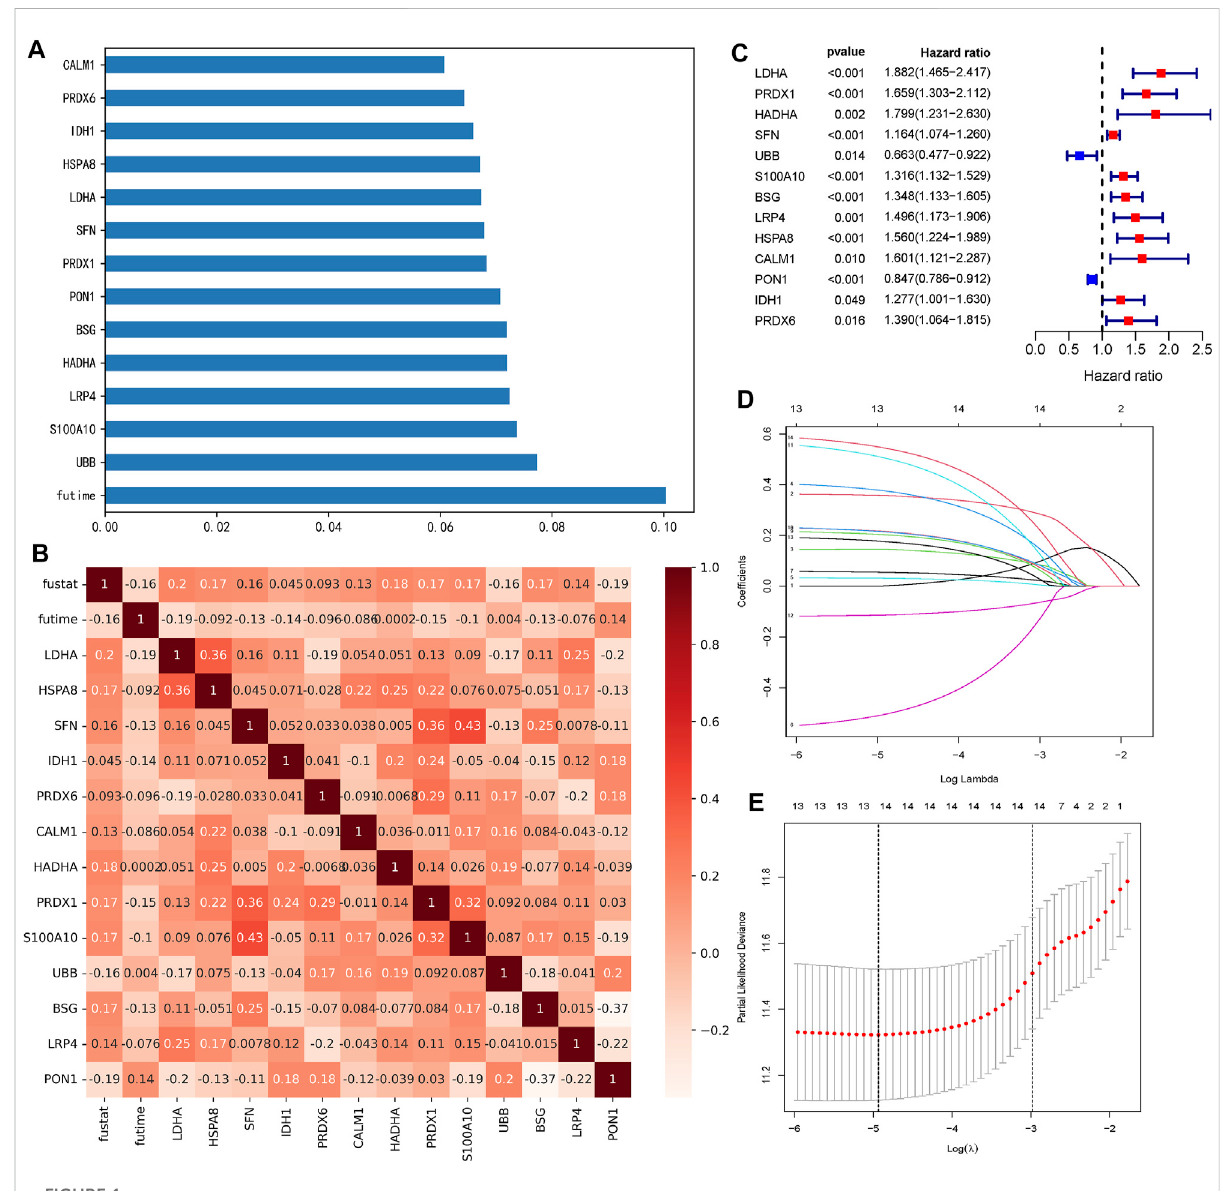
FIGURE 1 Selection of 13 ERGs. (A) Feature importance of 13 ERGs (each gene > 0.06). (B) Heatmap of relationships among 13 ERGs with the survival time (futime) and survival state (fustat). Genes with the redder pattern color mean the greater correlation with the survival time and state. (C) Forest plots show the results of the univariate Cox regression analysis of 13 ERGs ( p < 0.05). (D) Ten-fold cross-validation for tuning parameter selection in the LASSO model. The solid vertical lines represent partial likelihood deviance ±standard error (SE) values. (E) LASSO coef fi cient pro fi les for the 13